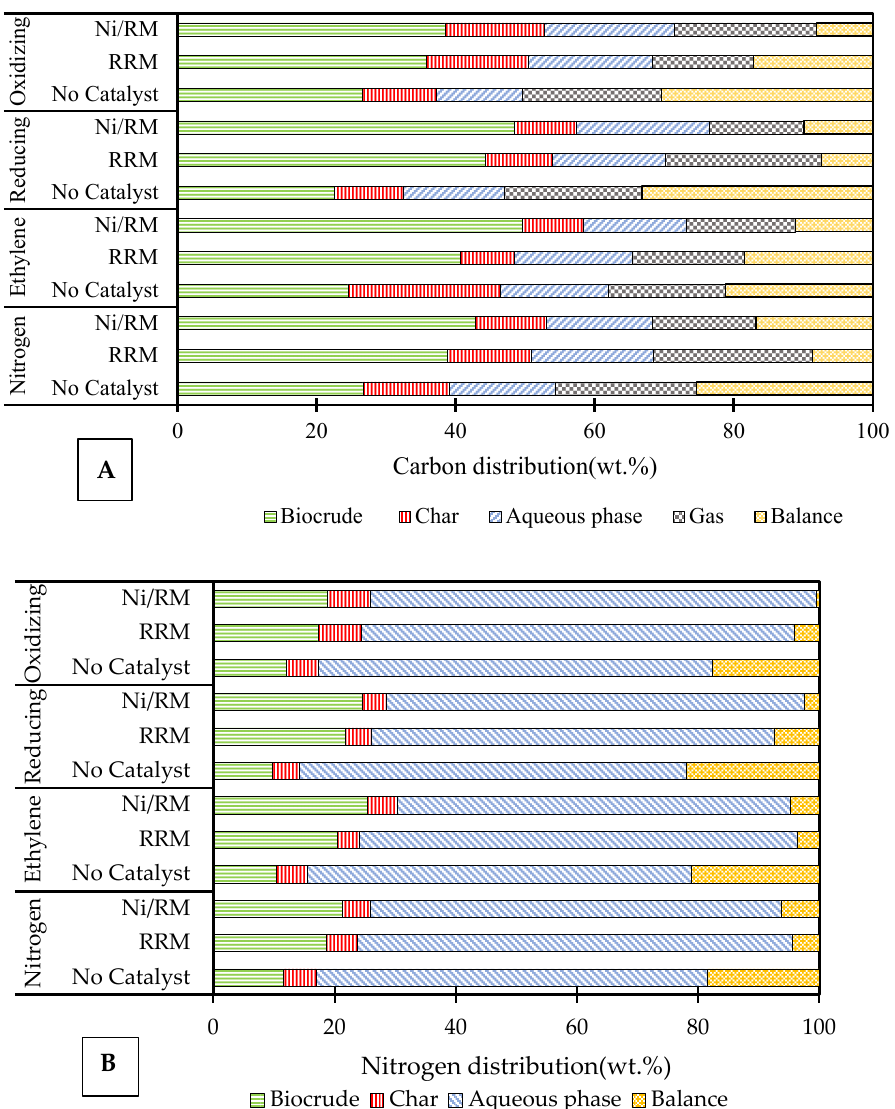
Figure 6. Carbon and nitrogen distribution in Tetraselmis HTL products, ( A )—Carbon distribution, and ( B )—Nitrogen distribution.